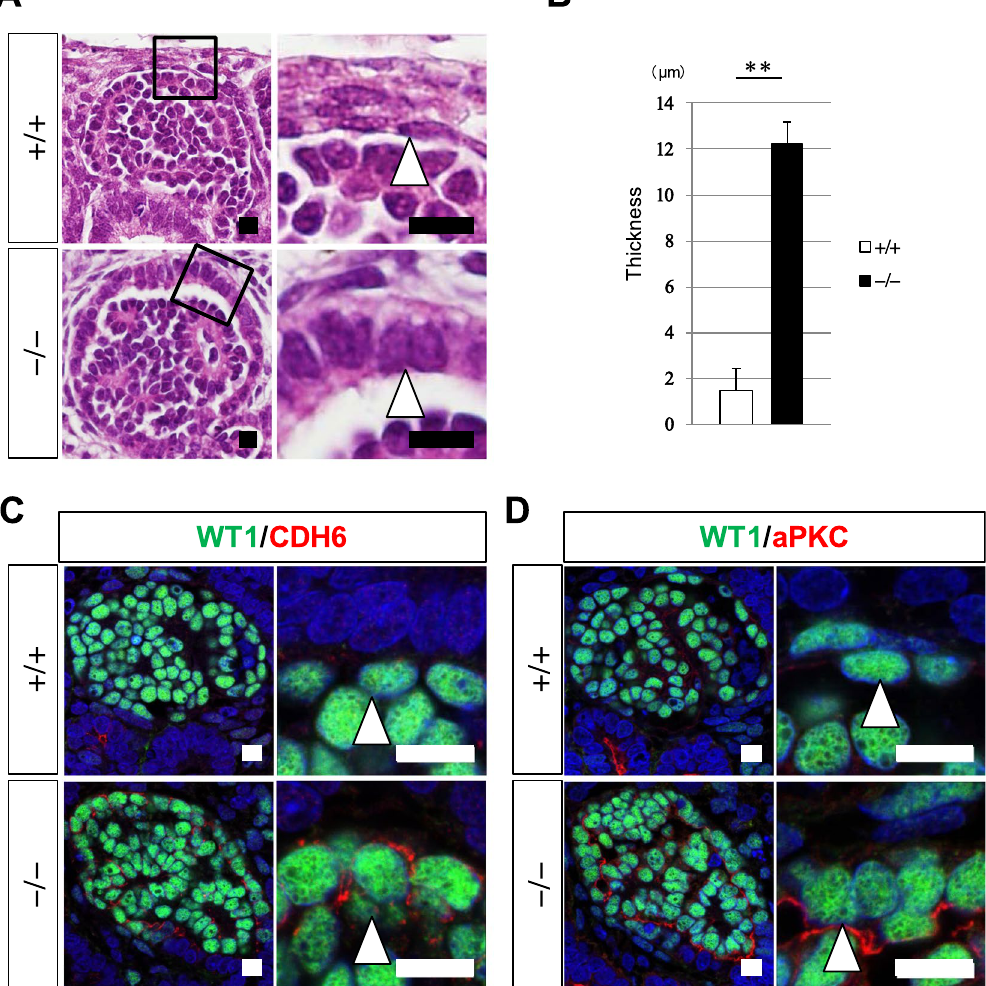
Figure 5. Human PAX2 is required for morphogenesis of glomerular parietal epithelial cells. ( A ) Hematoxylin– eosin staining of glomerular parietal epithelial cells from the wild-type and PAX2 -null iPS cells. Note the flat ( + / + ) and columnar ( − / − ) shapes. Right panels: magnified images of the squares. ( B ) Thickness of the glomerular parietal epithelial cells (mean ± standard error). ** p < 0.01. ( C ) CADHERIN6 (CDH6) is only expressed in the mutant glomerular parietal epithelia. ( D ) aPKC is only expressed in the mutant glomerular parietal epithelia. Arrows: glomerular parietal epithelial cells. Scale bars: 10 µ